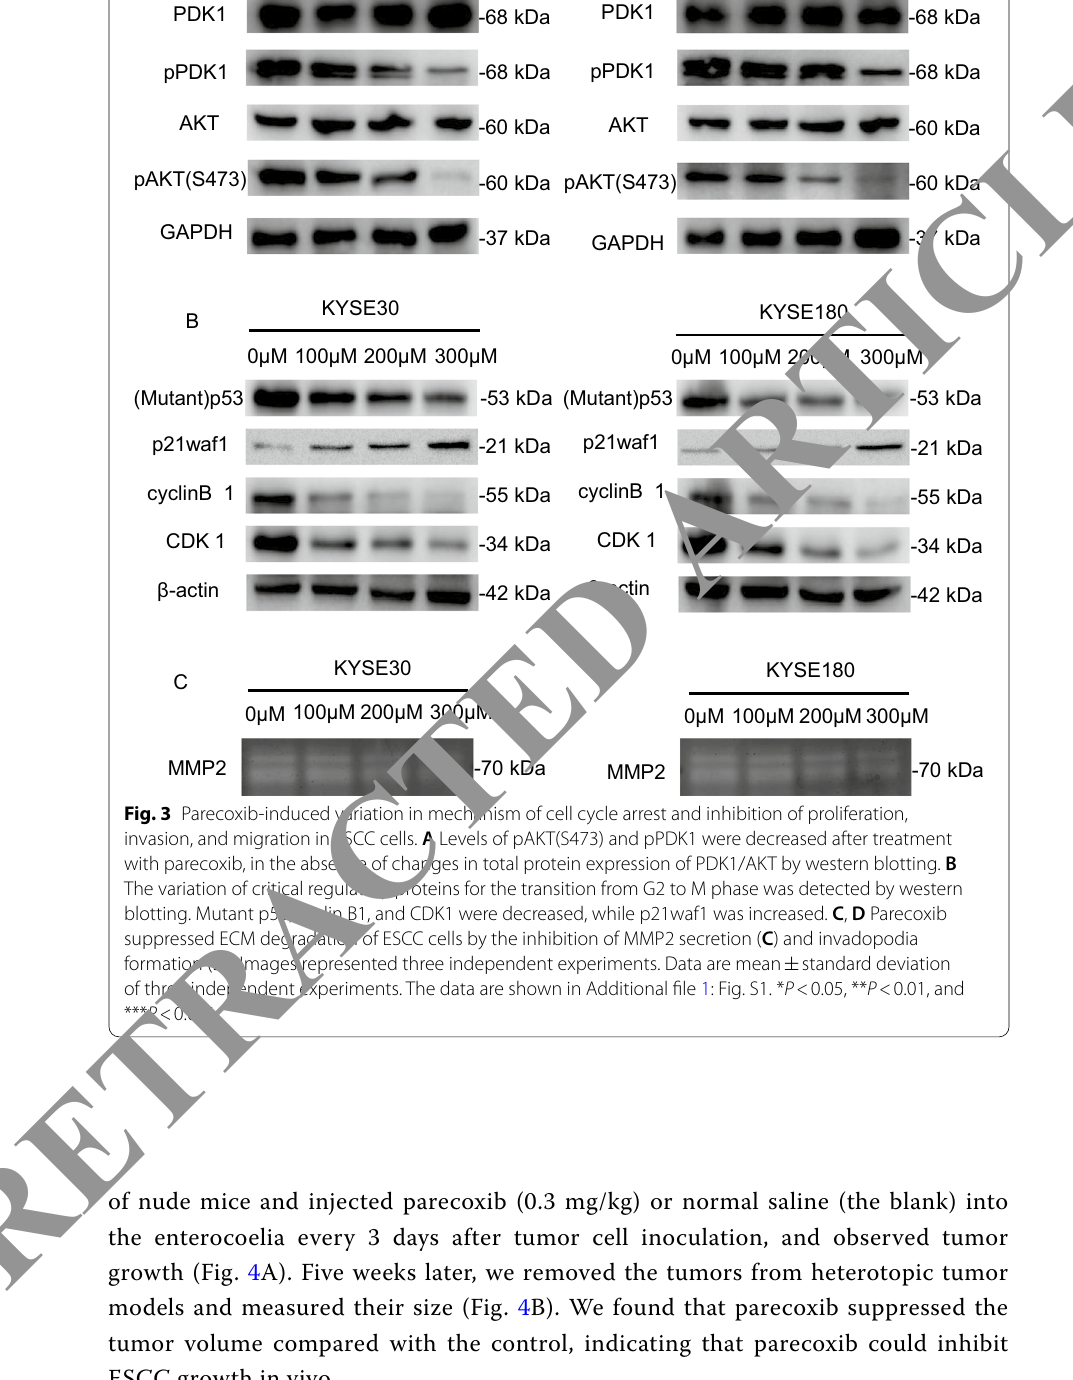
standard deviation ±